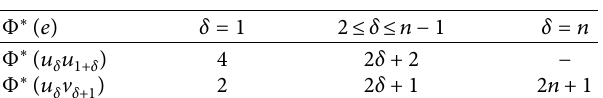
Table 8: Edge labeling of Φ ∗ ( e ) .